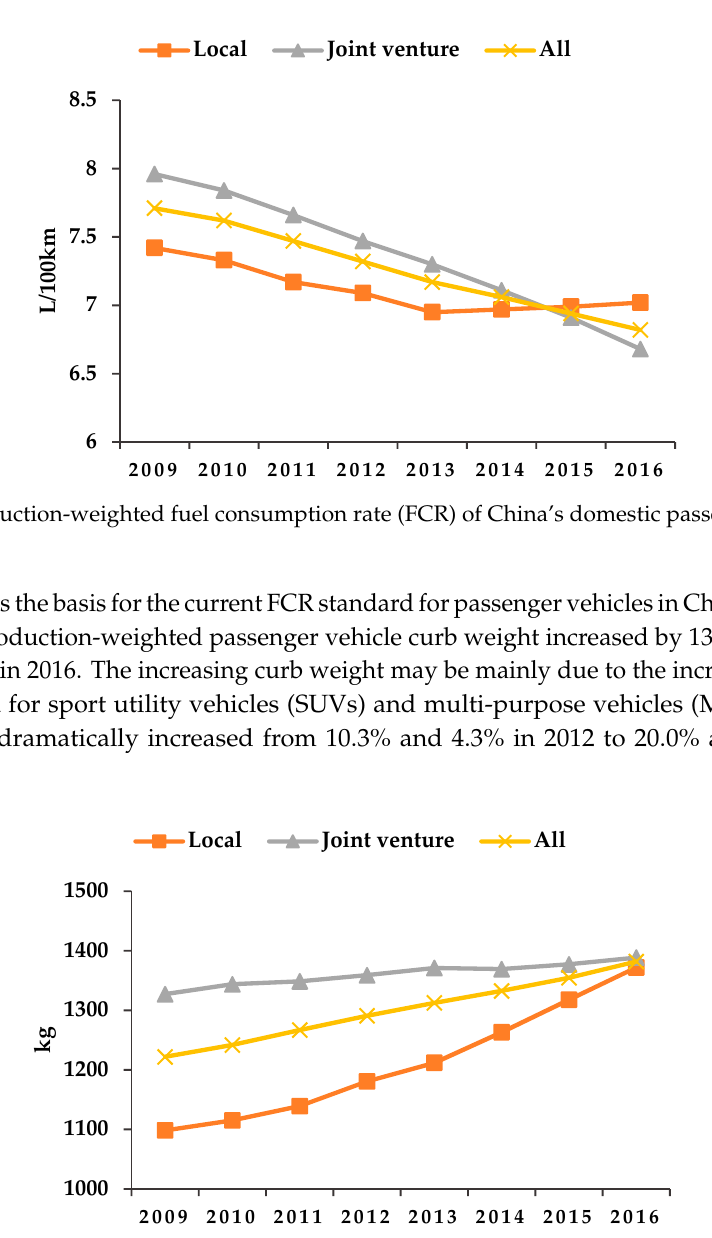
Figure 2. Production-weighted curb weight of China’s domestic passenger vehicles in 2009– 2016.